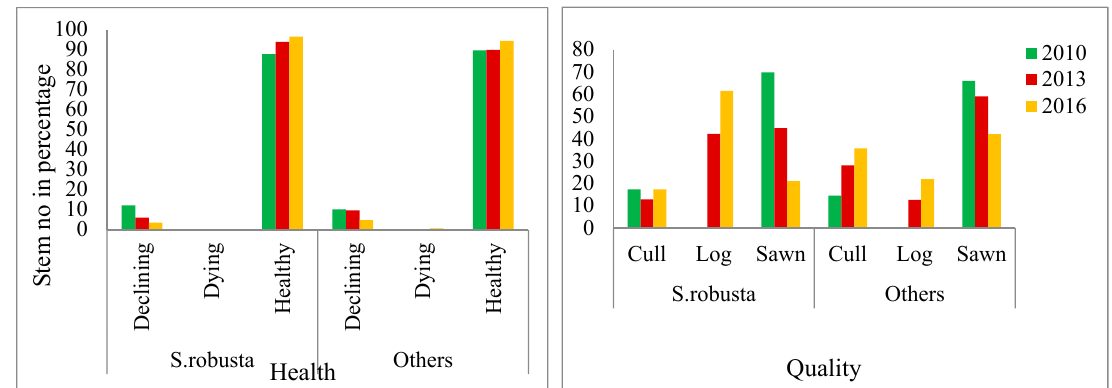
Figure 6. Tree health and quality of S. robusta and other species in percentage.